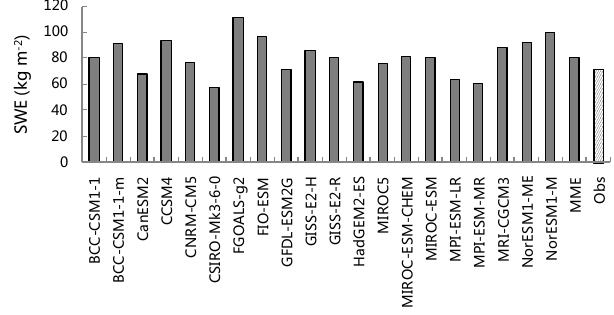
Figure 2. The average of the observed and simulated winter (DJF) mean SWE over non-mountain land areas of the Northern Hemisphere during 1980–2005. The multi-model ensemble (MME) refers to a combination of the 20 models listed in Table